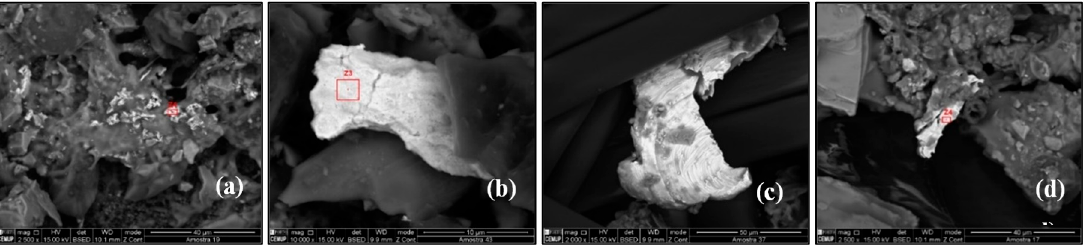
Figure 12. Scanning electron microscopy images ( a ) pyrolusite particle, ( b ) titanium particle, ( c ) brass particle, and ( d ) stainless steel particle.